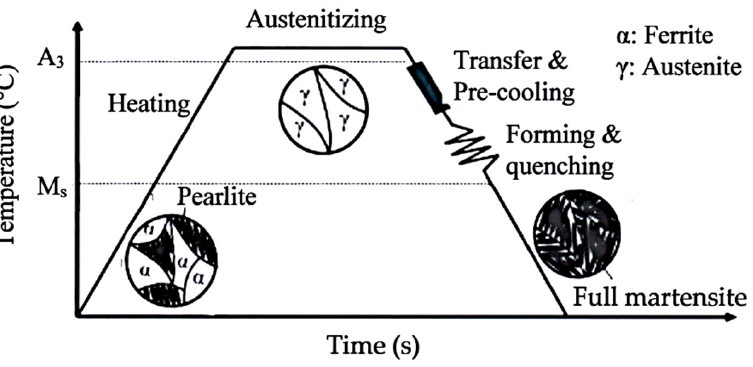
Figure 16. Schematic illustration of hot-stamping process at low-temperature and warm temperature [122].